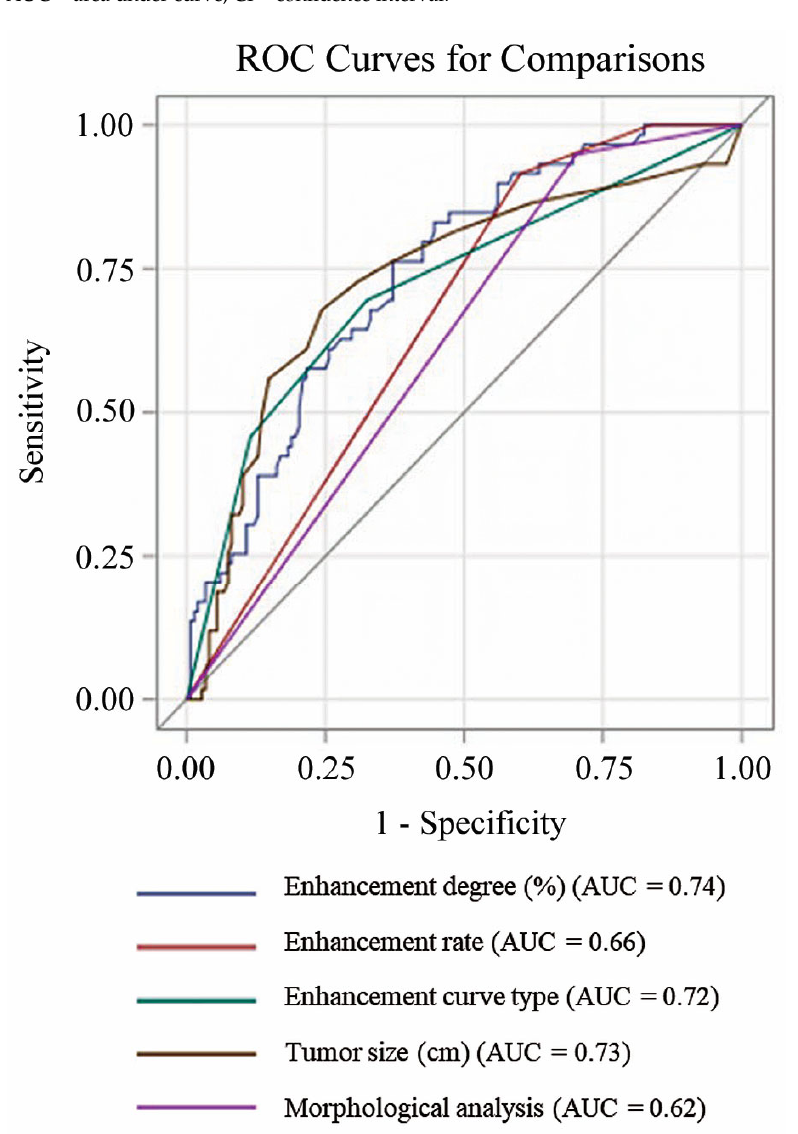
Figure 2. ROC curves of the parameters for differentiating malignant from benign breast lesions. ROC = receiver operating characteristic.